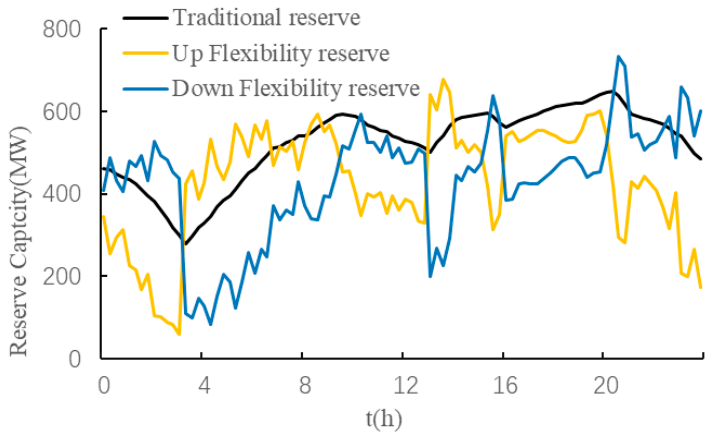
Figure 5. Comparison of reserve between the proposed method and traditional one.